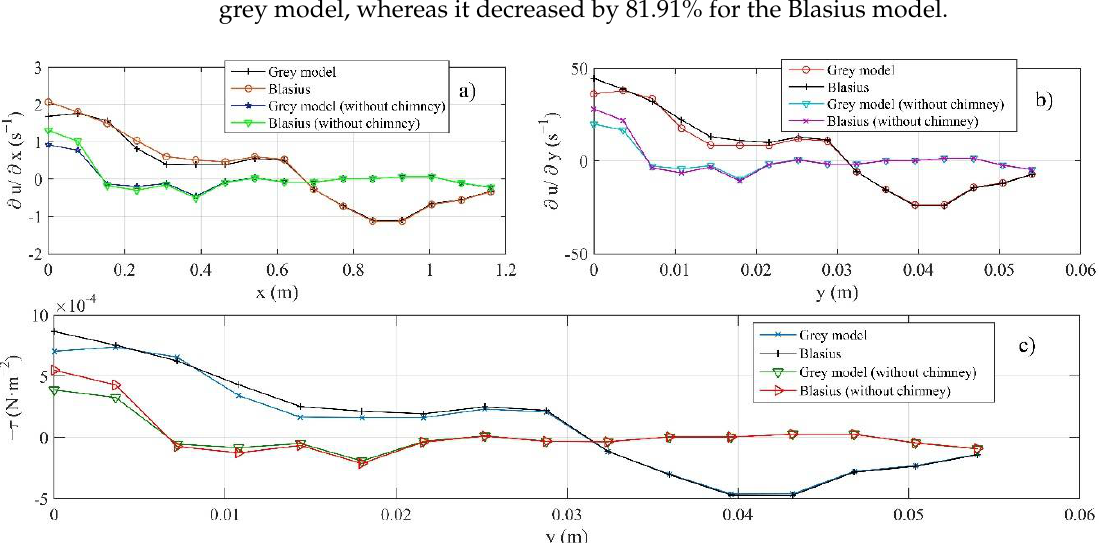
(cid:16) (cid:17) ∂ u for the conventional system dropped by 88% for the ∂ x